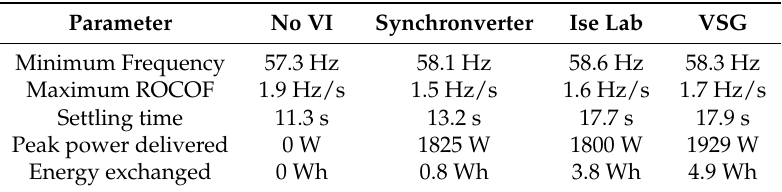
Table 2. Performance comparison of systems without virtual inertia (VI), and VI implemented